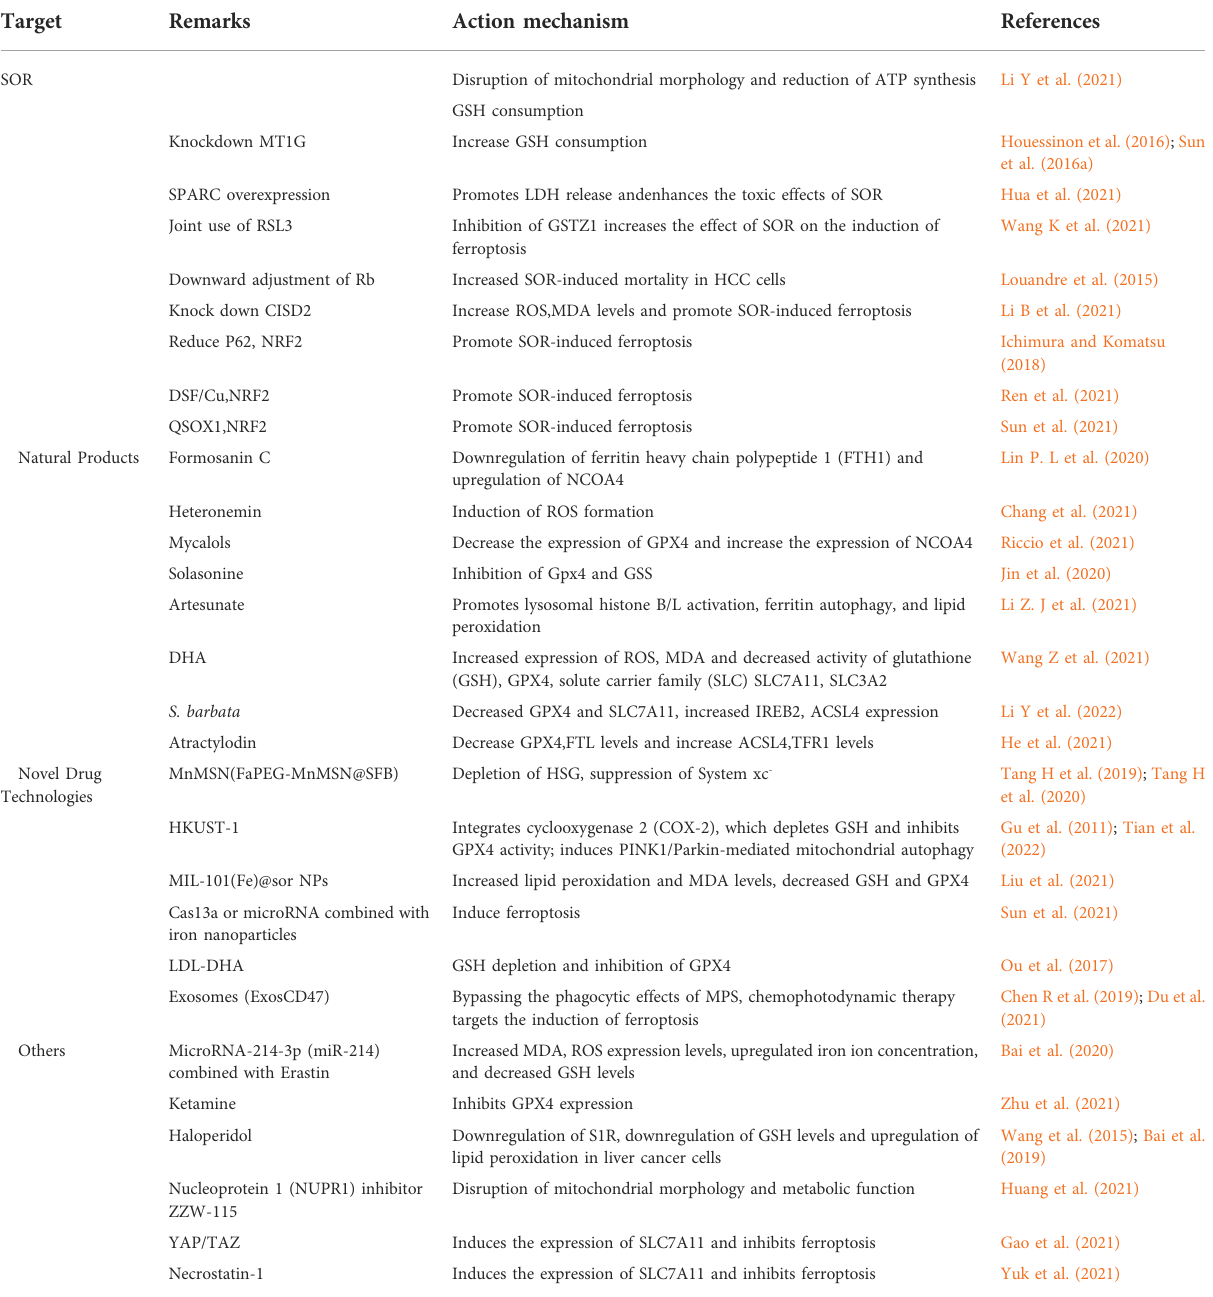
TABLE 2 Drugs and pathways of action related to ferroptosis in